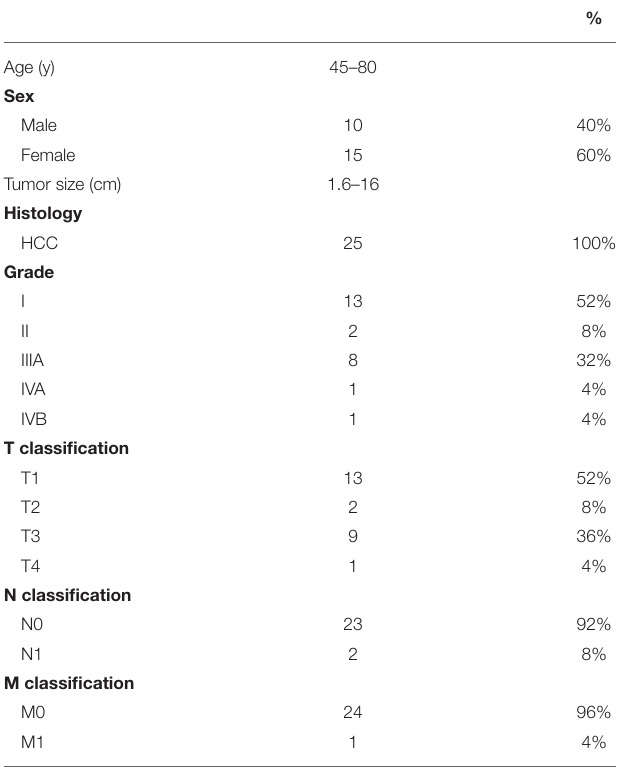
TABLE 1 | Clinicopathologic features of HCC